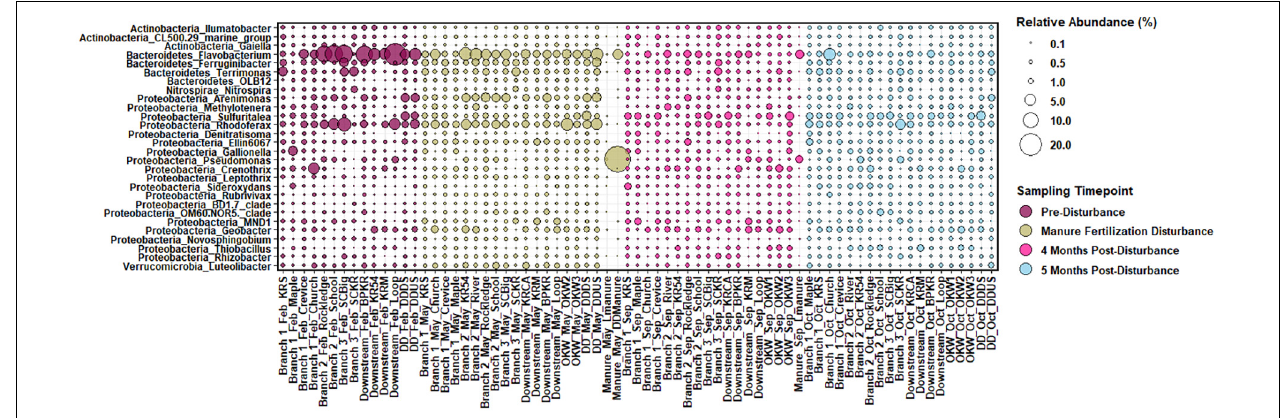
FIGURE 2 | Relative abundance of sediment and manure amplicon sequence variants (ASVs) mapped to “highly abundant” genera, or those with a relative abundance of at least 0.25% across all sediment samples displayed per sample. ASVs are named by Phylum_Genus on the y-axis and sample branch and date are indicated with the site name on the